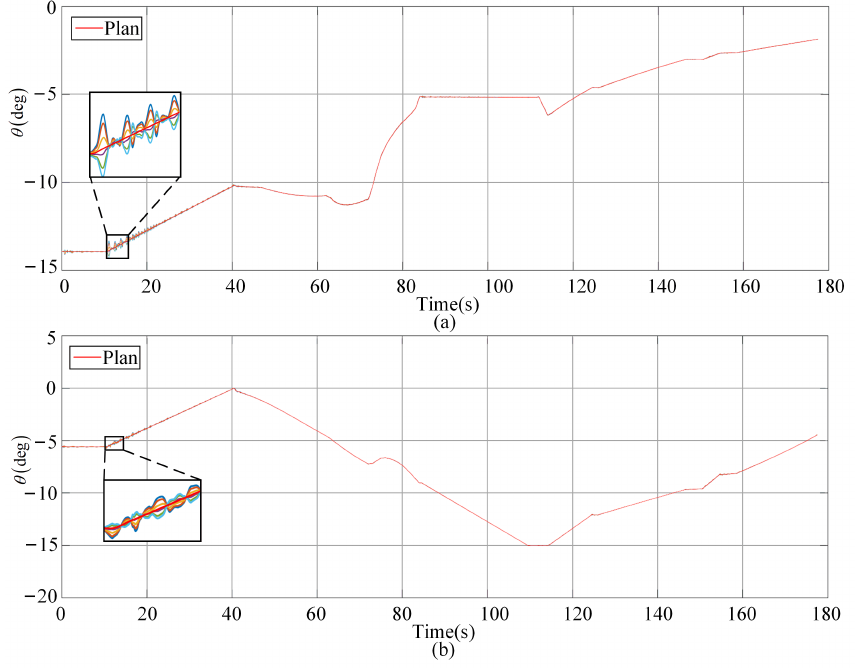
Figure 13. The comparison between the planning curve and the simulation curve of the six cross-axis joints of the 1st segment. ( a ) Alpha direction. ( b ) Beta direction.